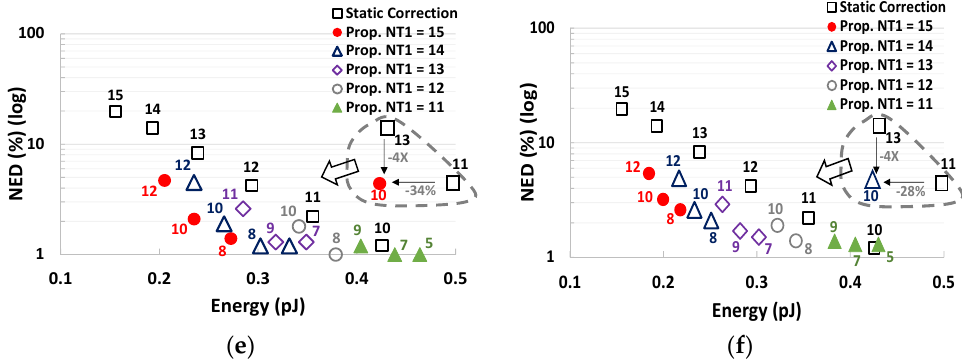
Figure 13. Energy-quality trade-off for the standard and proposed approaches: numbers close to the symbols indicate the values of N T (for the standard static approach) and N T 2 (for the proposed dynamic approach). ( a – c ): F = 4, ( d – f ): F = 8.